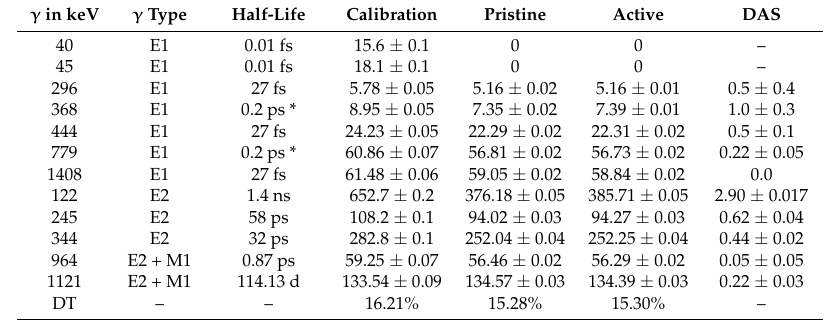
Table 1. Suppression of atomic channels (SAC) tested by a 30- µ Ci 152 Eu source. All